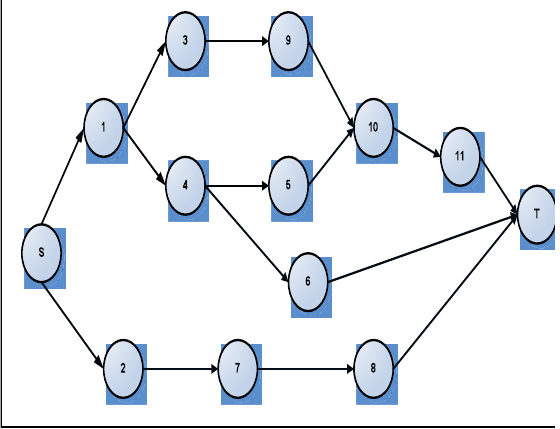
Figure 1. Precedence activity-on-node graph